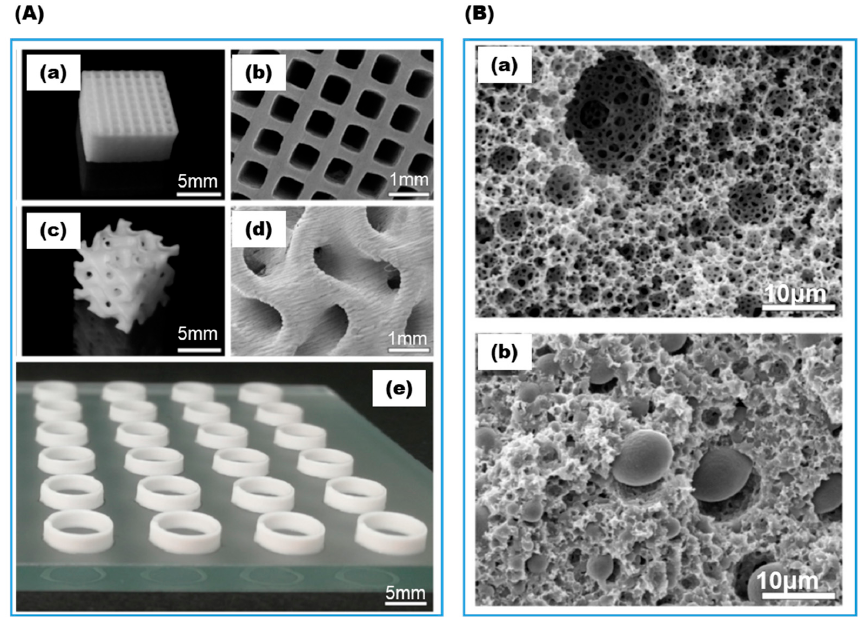
Figure 7. Hydrogel-filled high internal phase emulsion (HIPE). ( A ) The 3D printed scaffold: ( a , b ) cuboid grid structure with an edge length of 10mm and a height of 5 mm; ( c , d ) cubic gyroid structure with an edge length of 8mm; ( e ) hollow cylinders as used for activity assays. ( B ) Cross sectional morphology of HIPE: ( a ) no monomer in aqueous phase with empty voids and interconnecting pores between the voids; ( b ) with monomers in the aqueous phase forming hydrogel filling up the voids (adapted with permission from Ref. [44]).